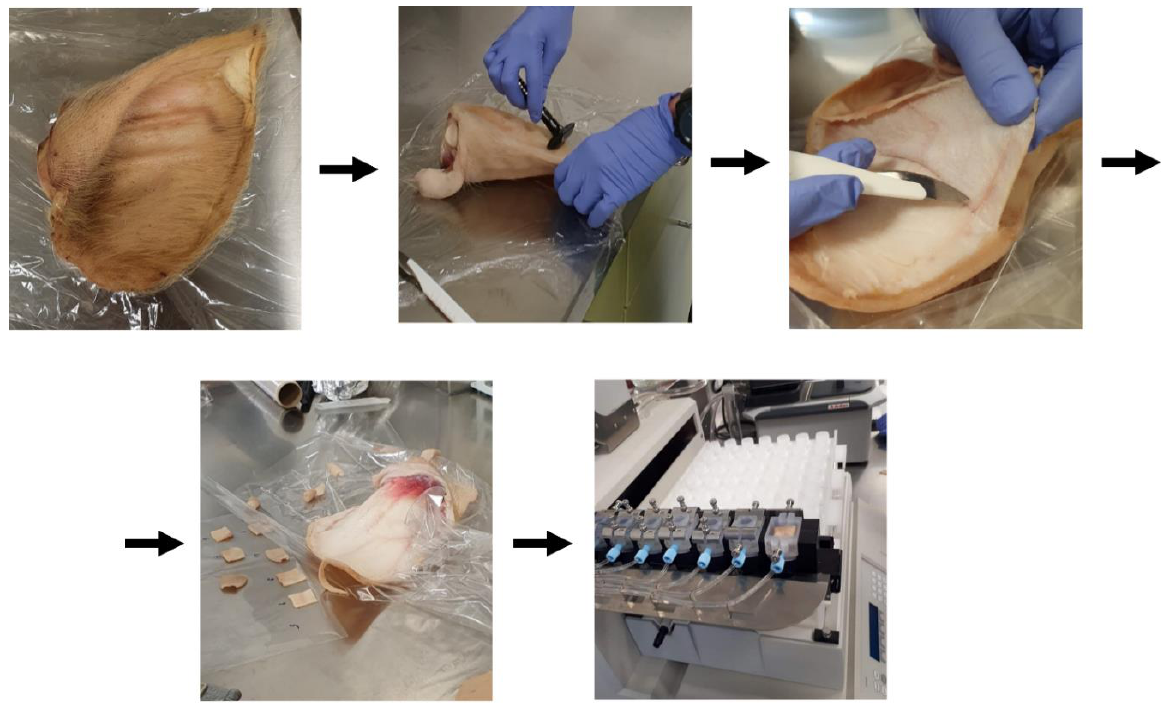
Figure 6. Generalized illustration of the test for transdermal absorption.